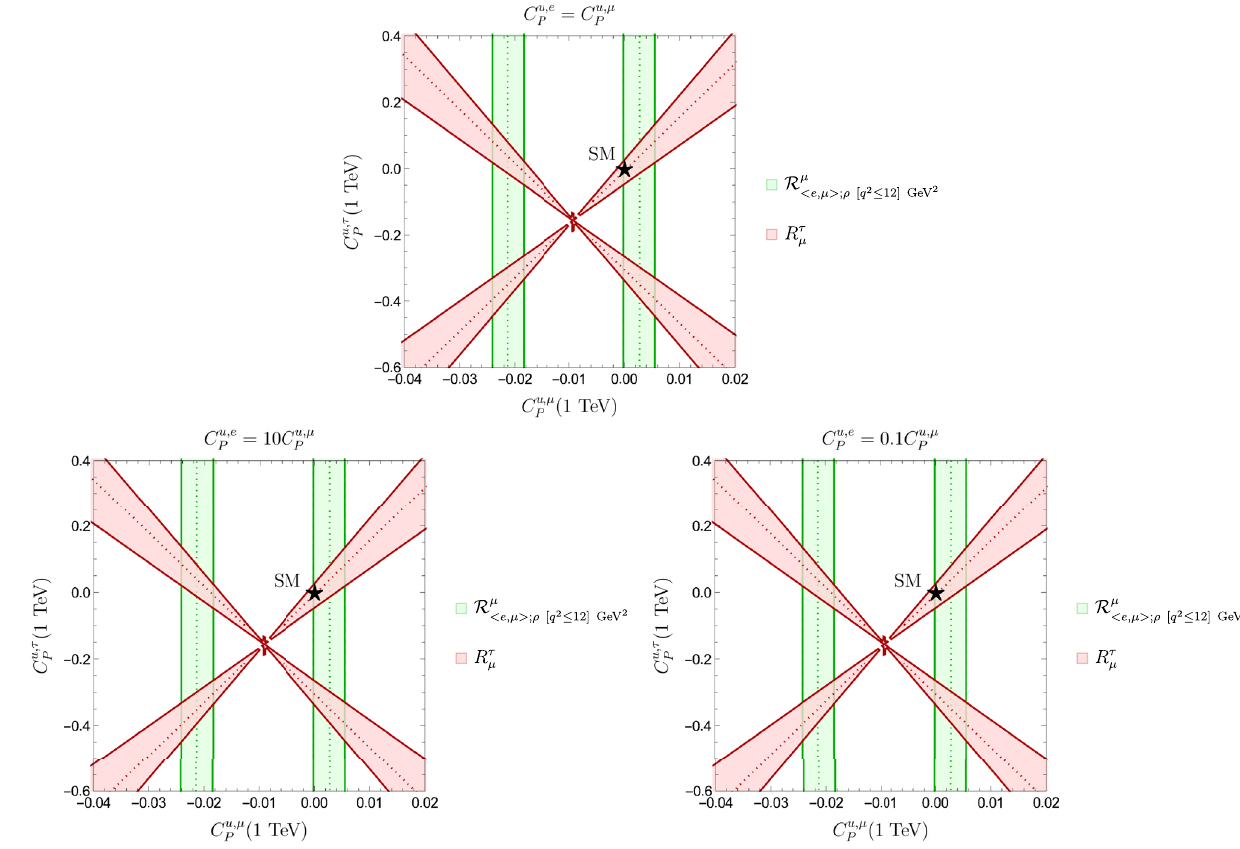
Fig. 1 Constraints on C u